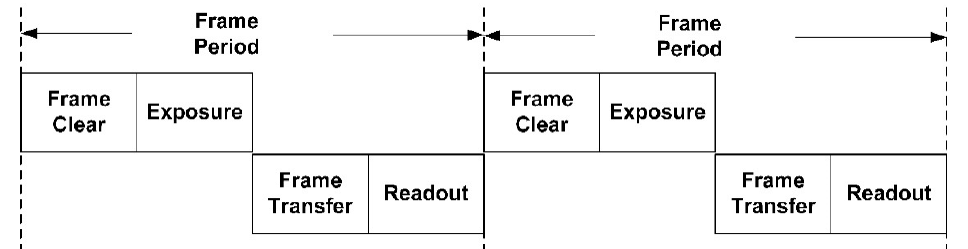
Figure 2. The Clear Mode driving timing of the CCD.